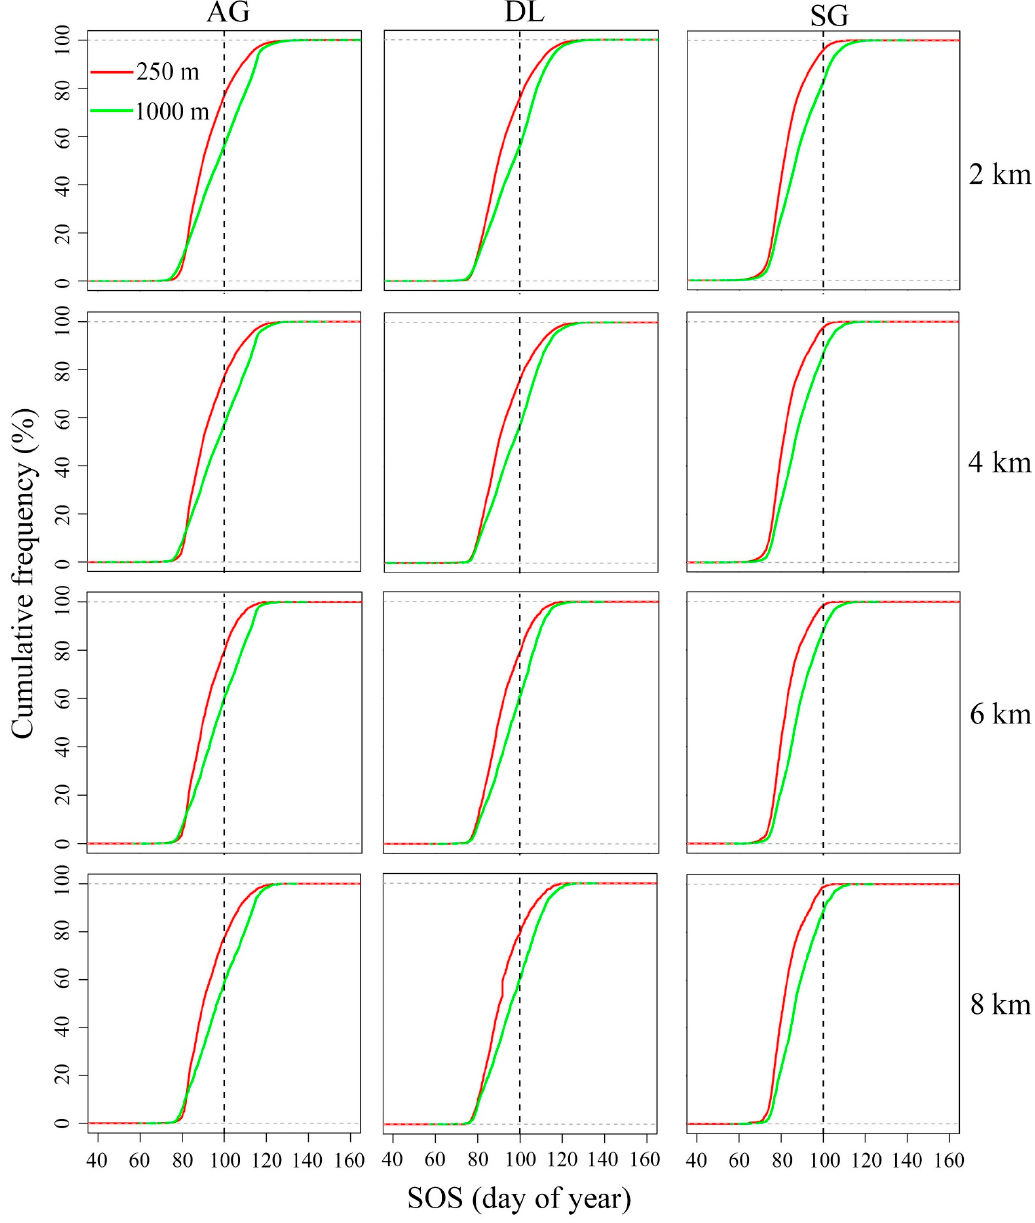
Figure 9. Cumulative distribution functions (CDFs) of the up-scaled SOSs from 250 m and 1000 m SOSs. (SG, Savitzky-Golay; AG, asymmetric Gaussian; DL, double logistic).